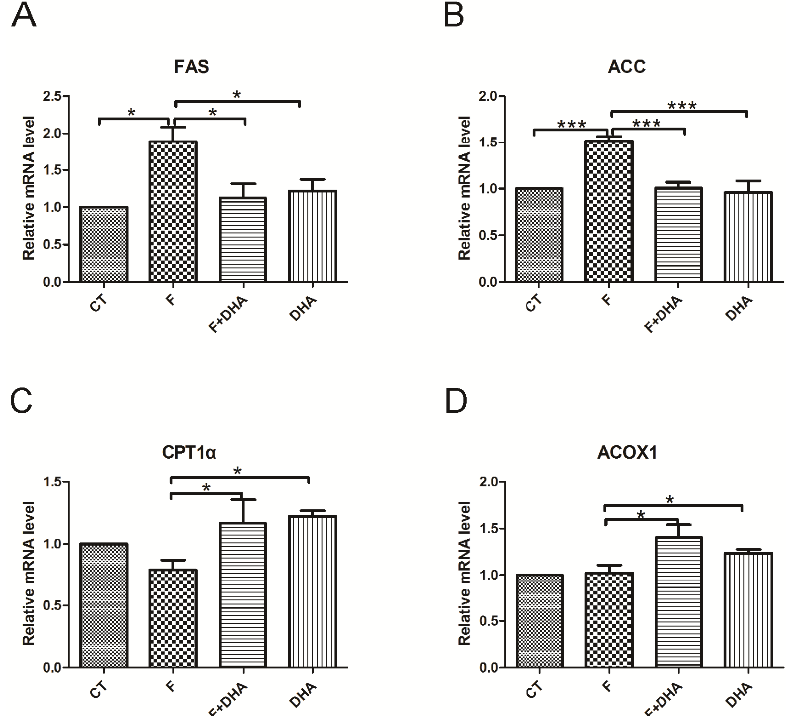
Figure 2. DHA regulates the expressions of genes involved in hepatic lipid metabolism. CT: control; F: fructose; F + DHA: fructose plus DHA. Expression values were normalized to control group. Data are expressed as mean ± SEM ( n = 4). Data of the four groups were compared by ANOVA with LSD’s test (* p < 0.05).